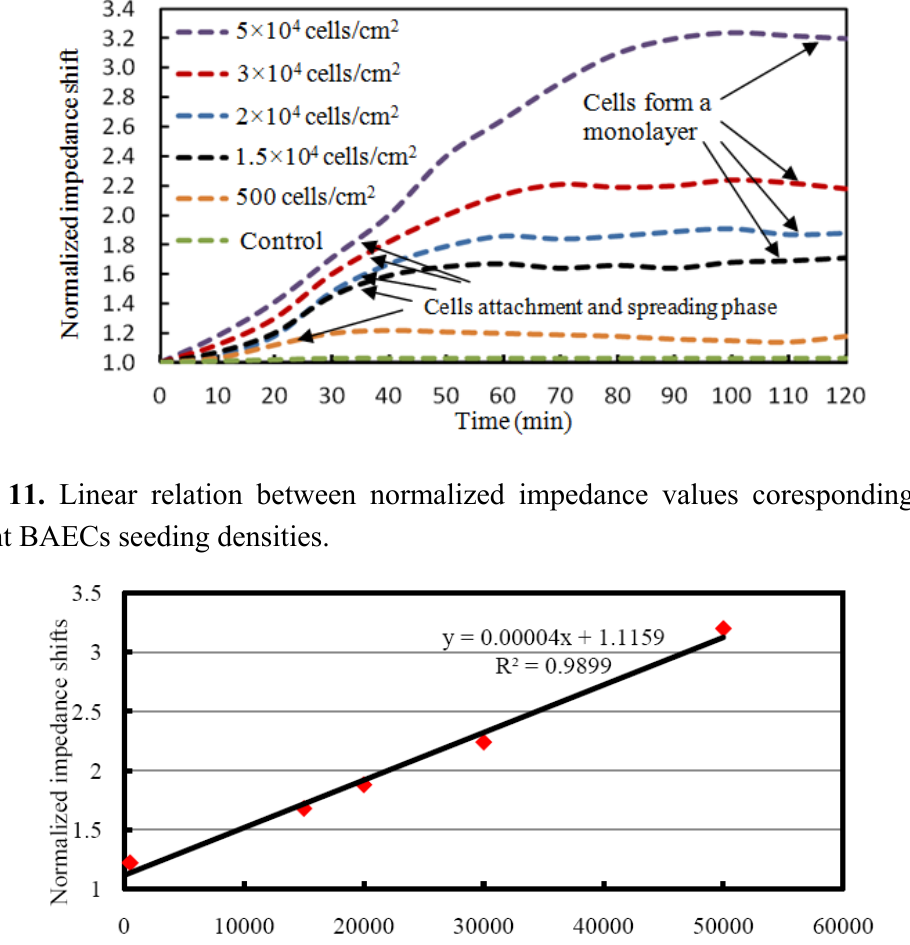
Figure 11. The normalized impedance values were obtained as the ratio between the impedance values of cells membrane and the impedance values of media without cells from the control well. The graph